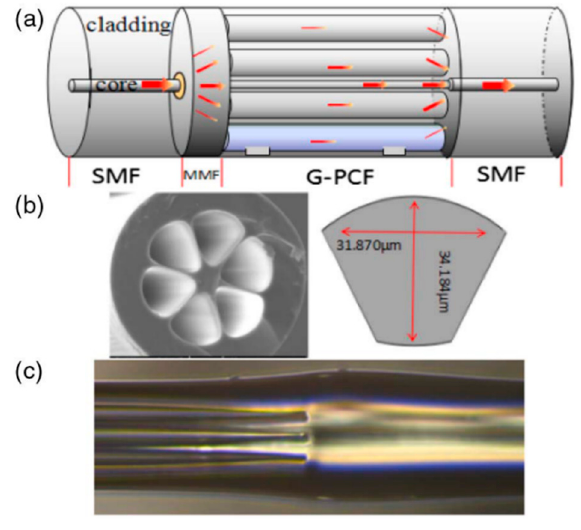
Figure 13. Schematic diagram of the MOF relative humidity (RH) sensor based on MZ interferometer; (a) cross section of the SC-PCF used; (b) optical microscopic image of the six-air-hole G-PCF cross-section structure and dimensions of the one of them; (c) zoom of the splice region between SC-PCF and SMF: the holes of the SC-PCF are completely collapsed. Reprinted with permission from [99] ©2018 Optical Society of America.